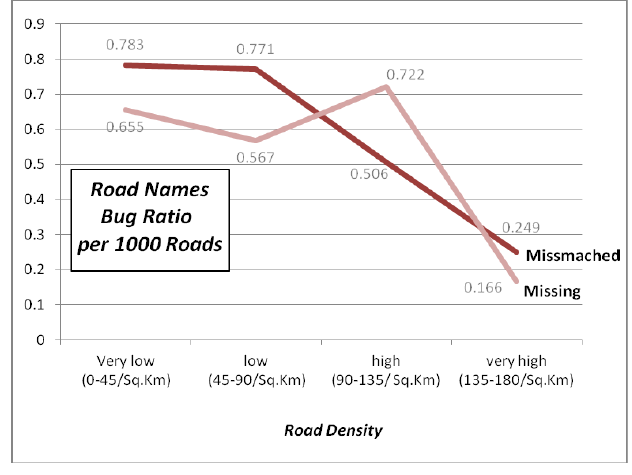
Figure 10. The graphs of bug ratios per 1,000 roads according to the four density bands. ( a ) The mismatched and missing road names; ( b ) the mismatched and missing road references; and ( c ) the total bugs